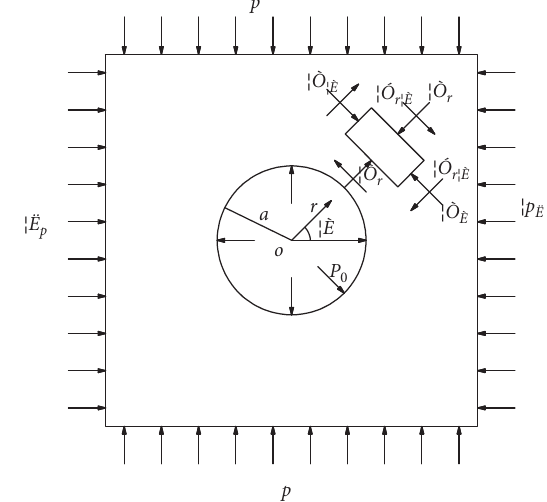
Figure 3: Mechanical model of the